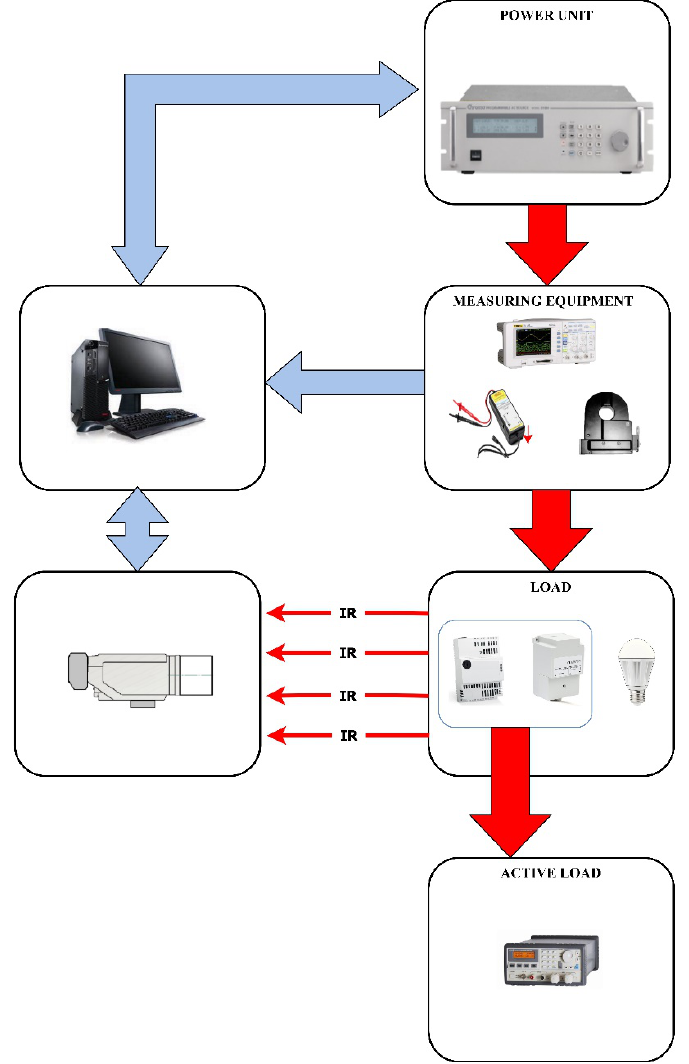
Figure 11. Applied measurement system.